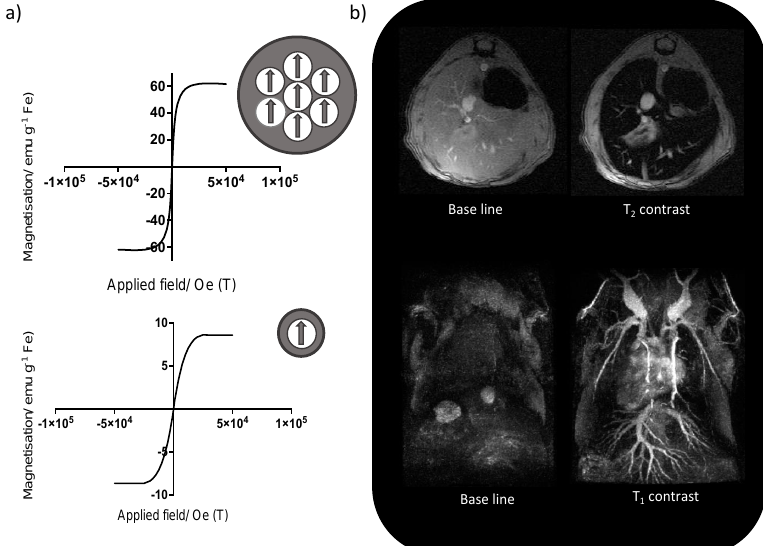
Figure 1. ( a ) Change in the magnetic behaviour of iron oxide nanoparticles with the decrease of the core size, from superparamagnetic (top) to paramagnetic (bottom), ( b ) Mouse liver T 2 -weighted MRI using iron oxide nanoparticles with bigger core size (top), T 1 -weighted MR angiography using iron oxide nanoparticles with smaller core sizes (bottom).